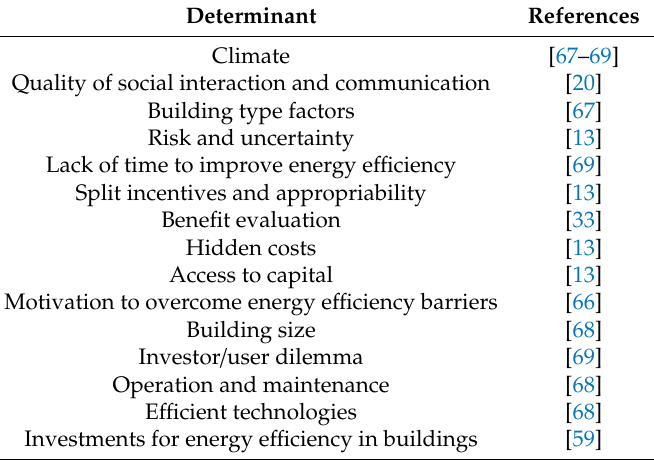
Table 5. Sociodemographic determinants in public